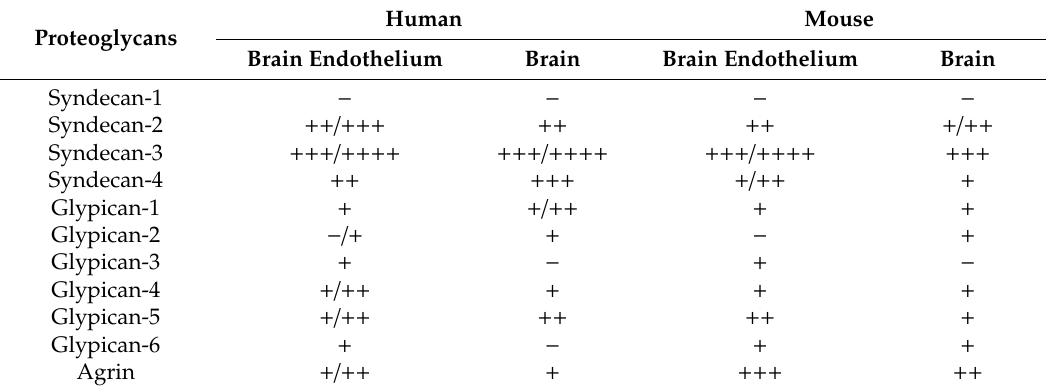
Table 2. Proteoglycans expression in human and mouse brains and brain endothelia. Adapted from [37]. Human Mouse Proteoglycans Brain Endothelium Brain Brain Endothelium